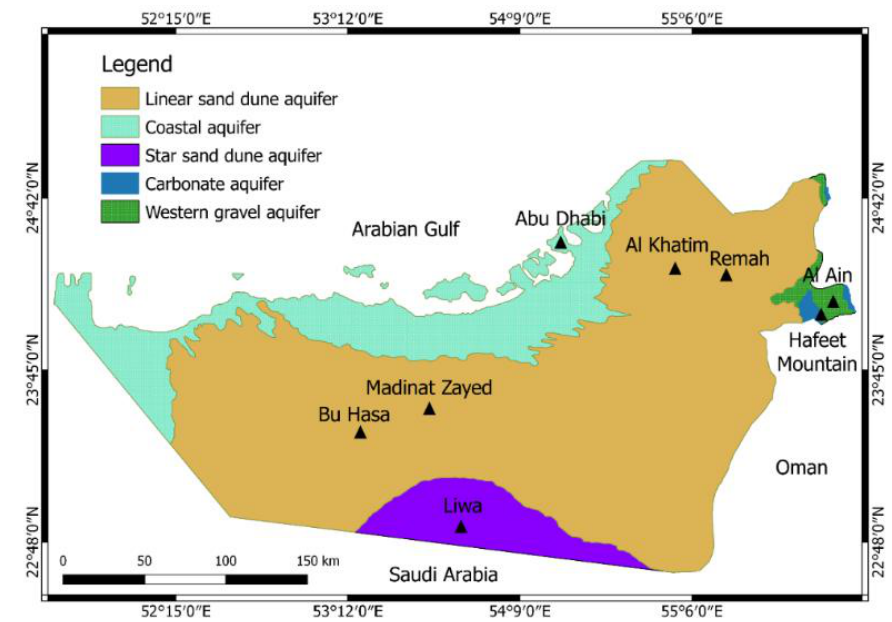
Figure 3. Maps of the Abu Dhabi groundwater aquifers (modified after Elmahdy and Mohamed [24]).